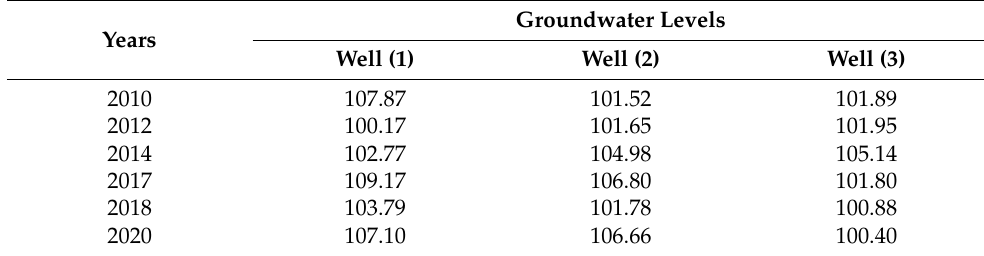
Table 3. Groundwater levels for three selected observation wells for different years in study